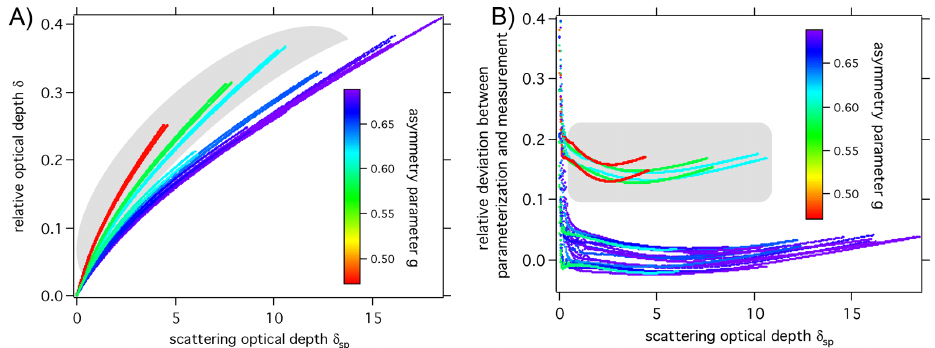
Figure 10. (a) Measured relative optical depths versus measured scattering optical depths for the three wavelengths of two PSAPs. The particle asymmetry parameter is color coded. (b) Relative deviation of measured and parameterized optical depths defined by (cid:0) δ meas − δ param (cid:1) /δ meas . The greyish areas indicate data with high scattering Ångström exponents, for which the parameterization has a higher